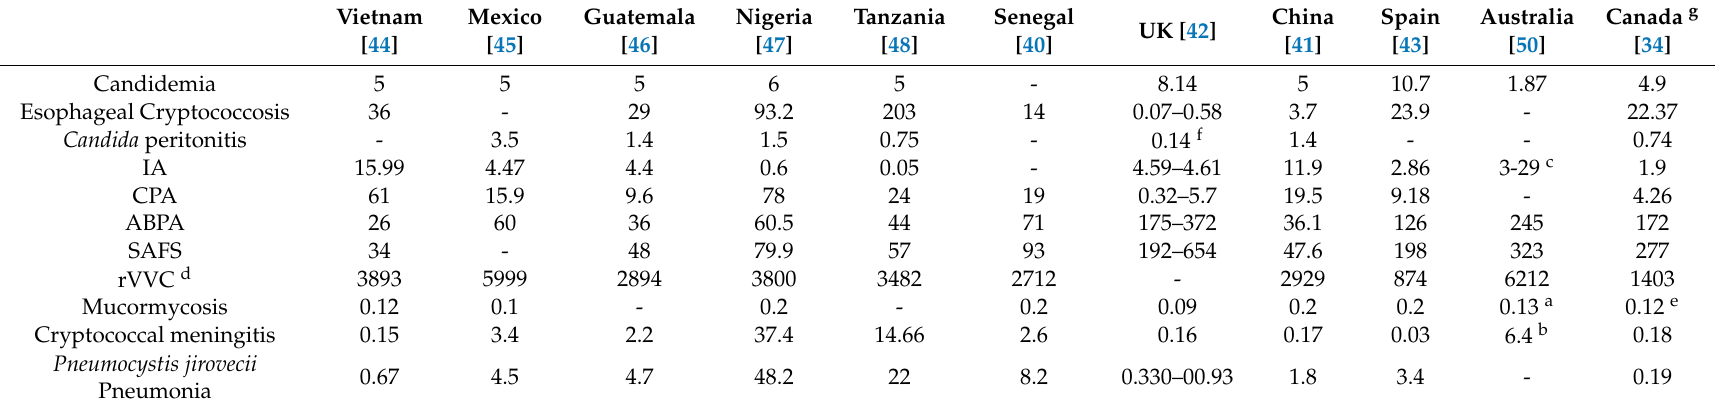
Table 3. Burden of serious fungal infections of some world countries calculated as per 100,000